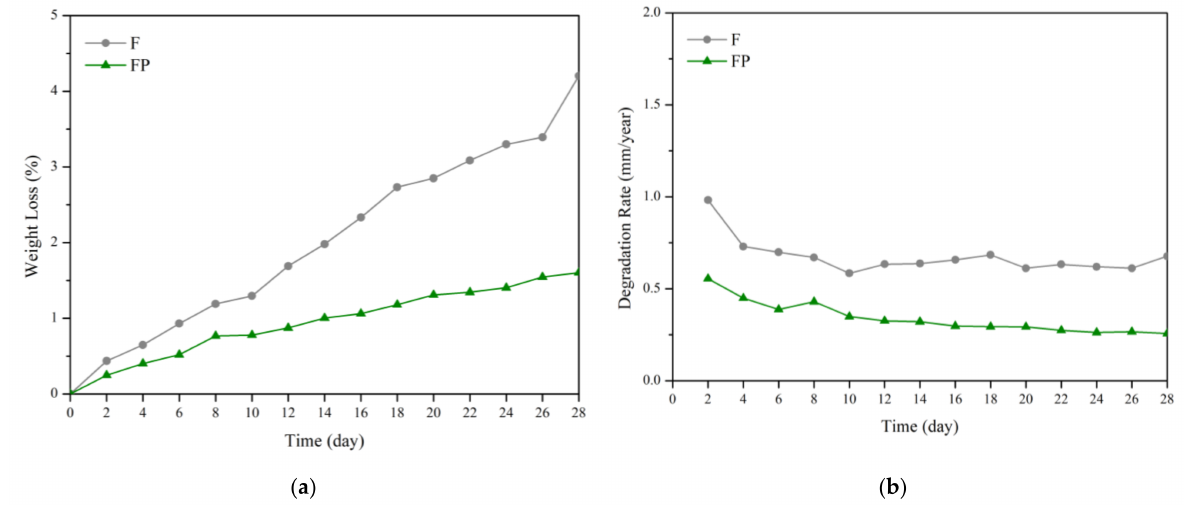
Figure 9. ( a ) Weight loss percentages and ( b ) degradation rates of F and FP in the SBF immersion test.